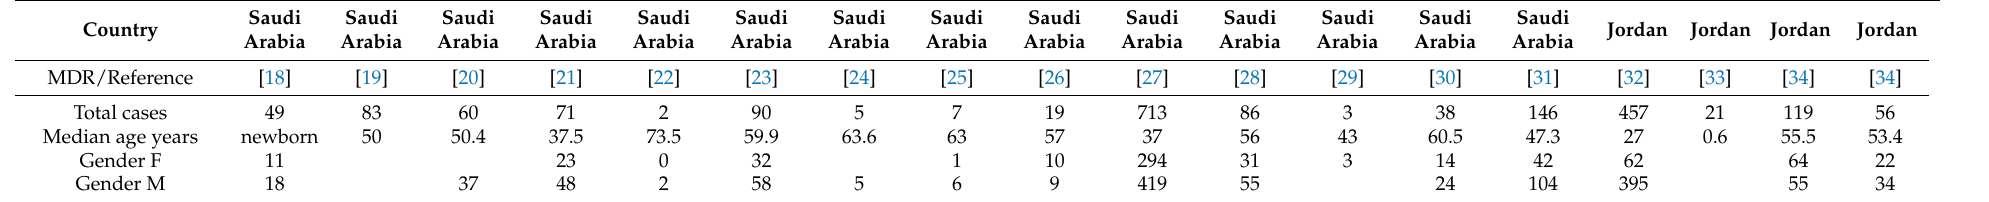
Table 4. Reports of mortality caused by MDR microbial infection from Saudi Arabia and